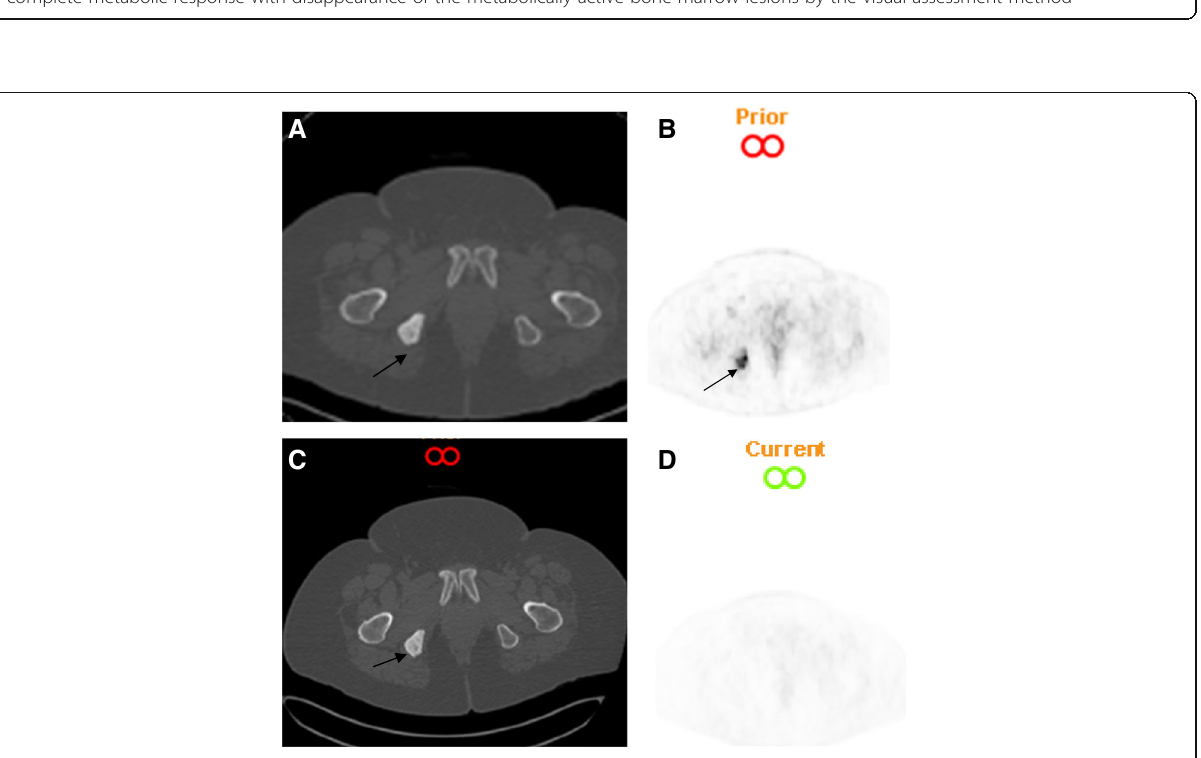
Fig. 3 Assessment of treatment response of patient with history of cancer breast and isolated bony metastatic disease with sclerotic metastatic lesions. a Axial CT bone window setting with sclertoic lesion noted in the rigth ischium (arrow). b Corresponding PET image showing avid uptake in the right ischium anatomical site. c Axial CT pelvis 6 months post treatment PET/CT study with sclerotic morhpolgy of the right ischium could represent sclerotic metastatic lesion or healed lesion. d Corresponding PET image shows no uptake within the lesion impressive of complete metabolic